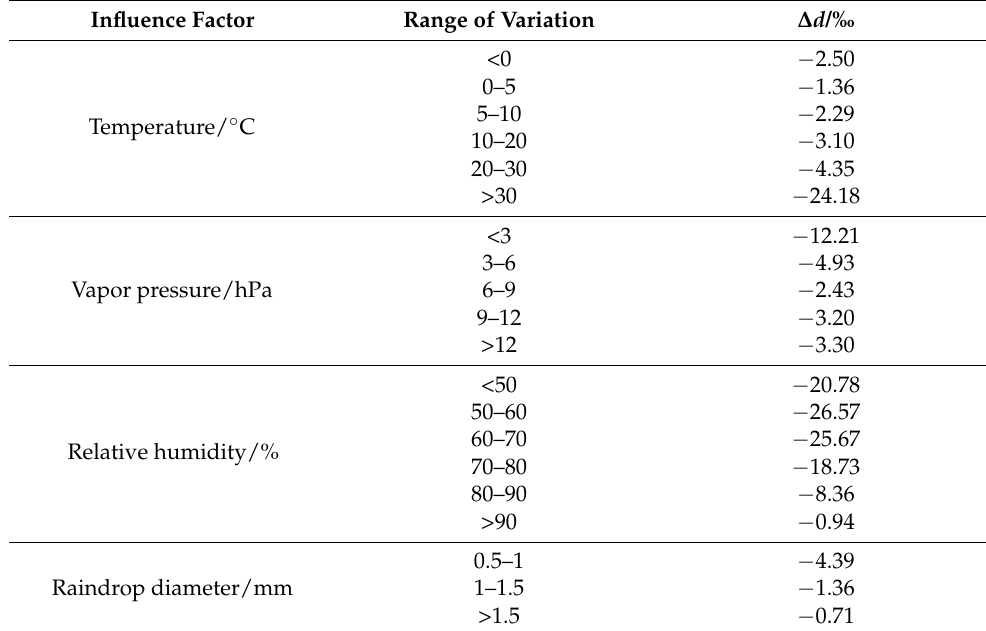
Table 2. Relationship between meteorological elements and ∆ d in the Yangtze River Basin. Influence Factor Range of